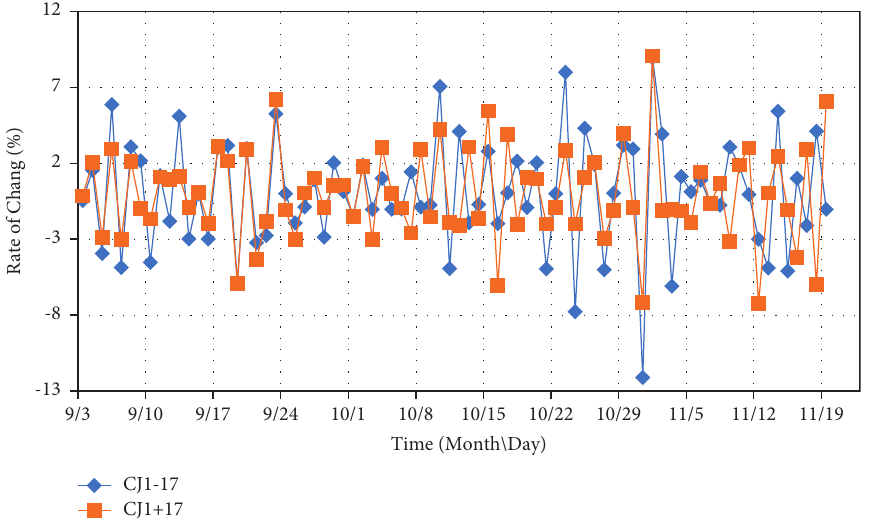
Figure 5: Rate of change of daily settlement (CJ1-17 and CJ1